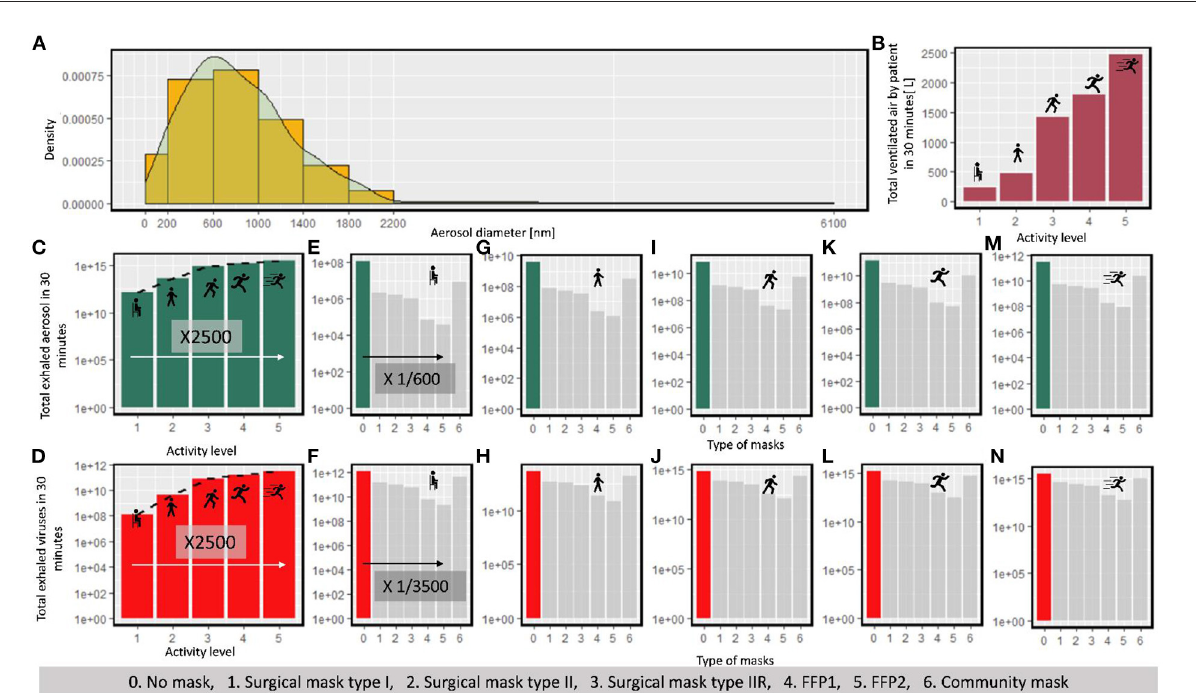
FIGURE5 (A) diameter distribution of exhaled aerosols by the infected person, (B) accumulated ventilated air by the infected person, (C,E,G,I,K,M) total exhaled aerosols, (D,F,H,J,L,N) total exhaled viruses during five activity levels (sitting, walking, moderate activities, running, and sprinting) by